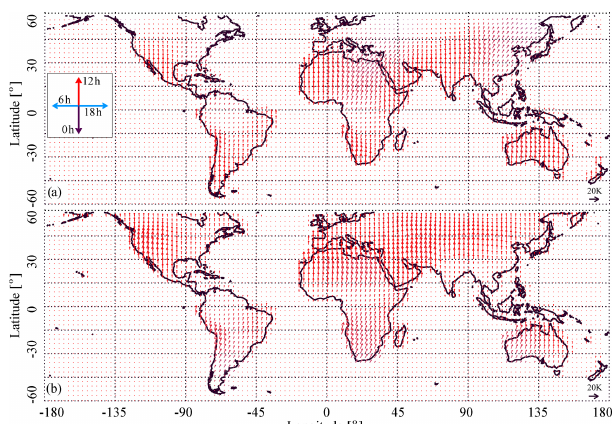
Figure B1. Diurnal variation of surface temperatures, estimated from ERA-Interim reanalyses, in January (a) and in July (b) . The vector representation is consistent with the caption of Fig.